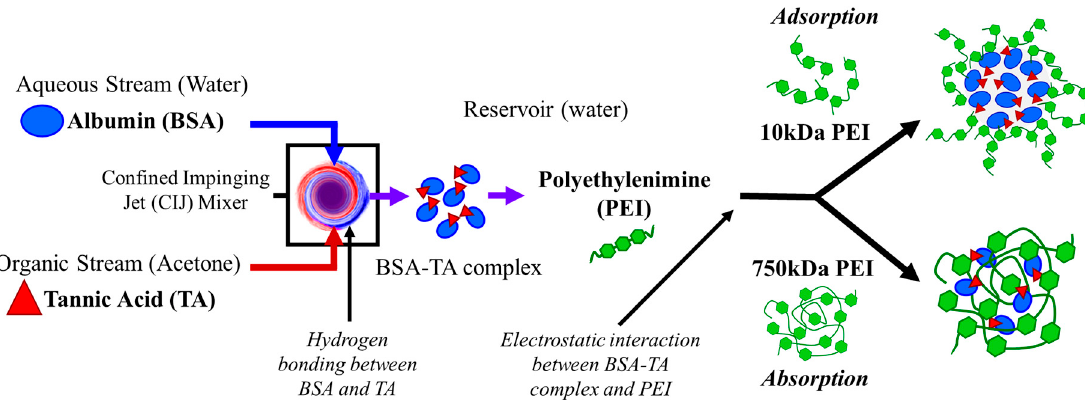
Figure 2. Schematic of the proposed self-assembly mechanisms using 750 kDa and 10 kDa polyethylenimine (PEI) via flash nanoprecipitation (FNP) with PEI stabilizer. In the confined impinging jet (CIJ) mixer the bovine serum albumin (BSA) and tannic acid (TA) interact via hydrogen bonding to form an insoluble complex. Then the complex is immediately diluted in a reservoir containing PEI. The BSA-TA complex interacts with the PEI via electrostatic interaction. High molecular weight 750 kDa PEI aggregates template nanoparticle assembly and absorb the BSA-TA precipitate. In contrast, 10 kDa PEI adsorbs on the precipitating BSA-TA complex forming a core-shell structure.